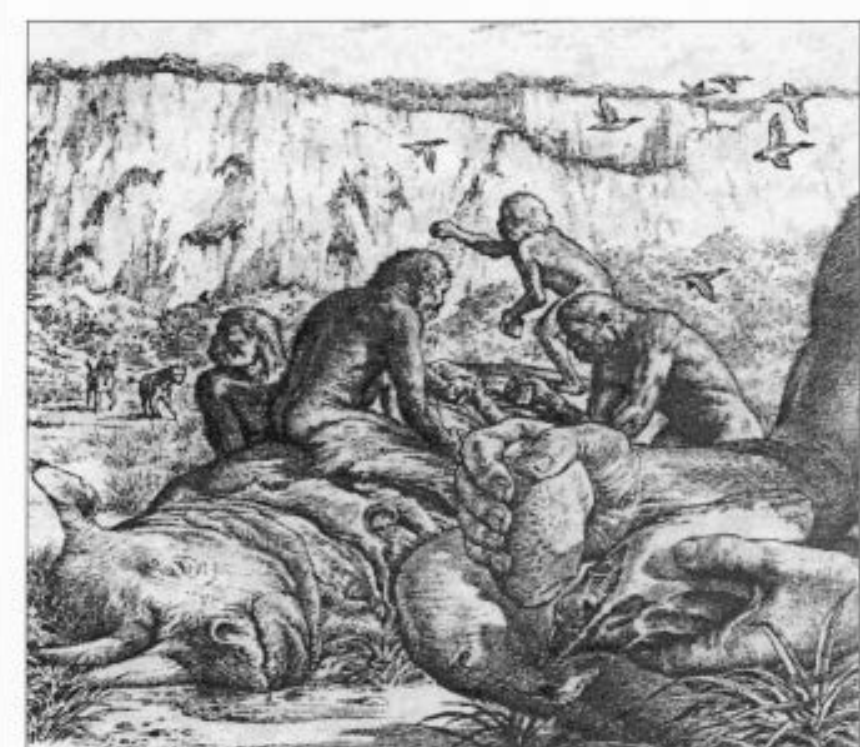
Figure 3 Reconstruction by John Sibbick of humans b utchering a rhinoceros carcass at the Boxgrove waterhole site. Stone biface tools were manufactured here with which large mammal carcasses were systematically processed, including the extraction of bone marrow (right foreground). The humans would have defended such valuable carcasses against other carnivores such as scavenging hyaenas (left background).